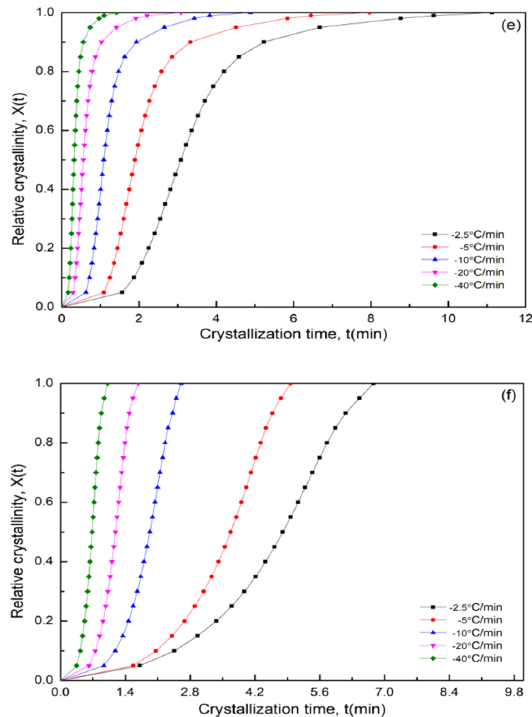
Figure 11. Relative crystallinity X ( t ) at different crystallization times t in the process of nonisothermal crystallization of ( a ) PA56, ( b ) CoPA-2, ( c ) CoPA-3, ( d ) CoPA-4, ( e ) CoPA-5 and ( f ) PA66. Table 5. Nonisothermal crystallization parameters of PA56/66 copolyamides at different cooling rates.